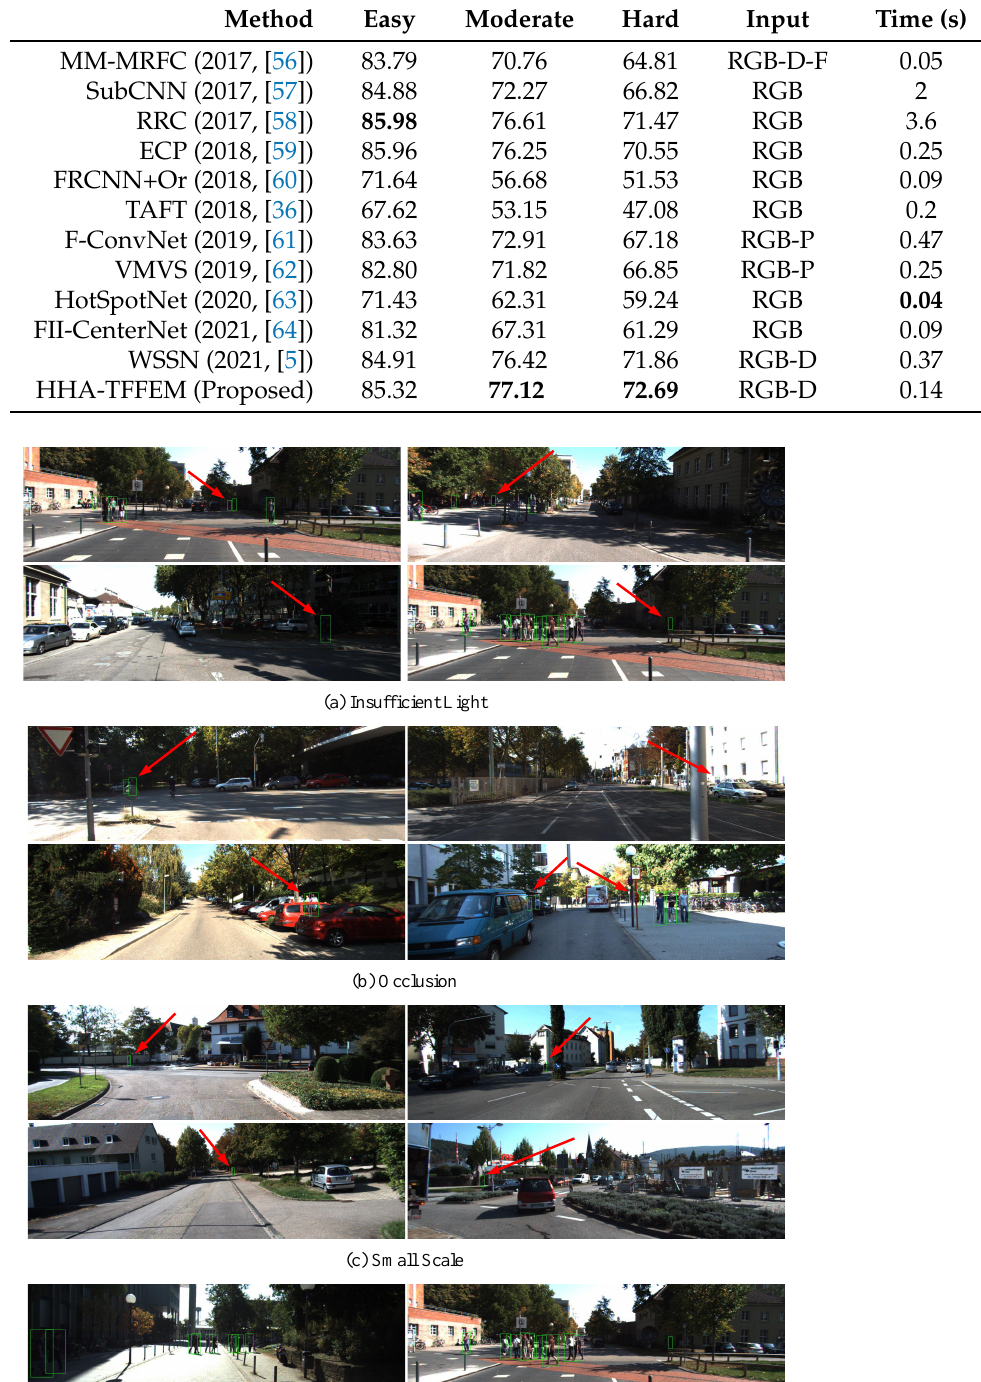
Table 1. Comparison with the state-of-the-art approaches on the KITTI test set for pedestrian detection.